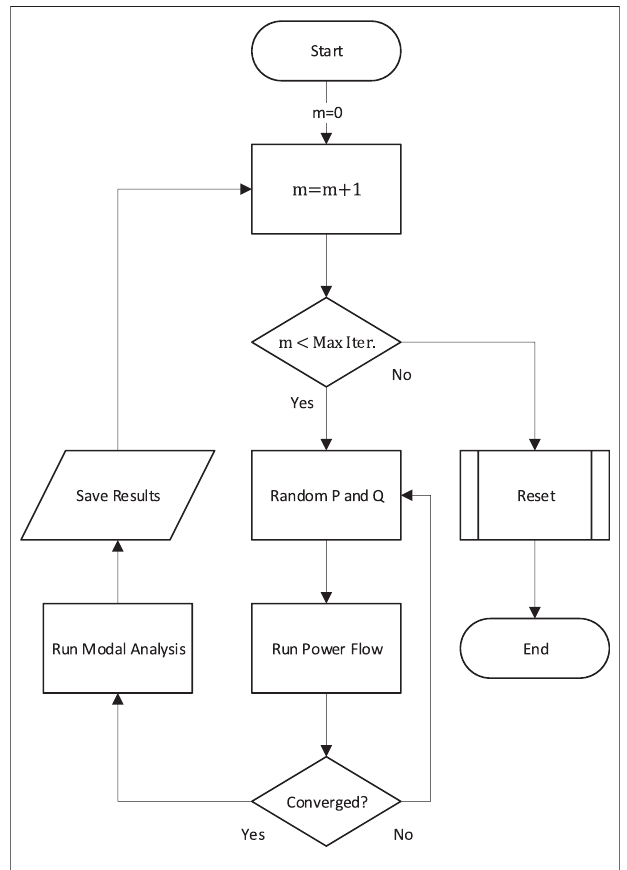
FIGURE 7 | Database generation fl